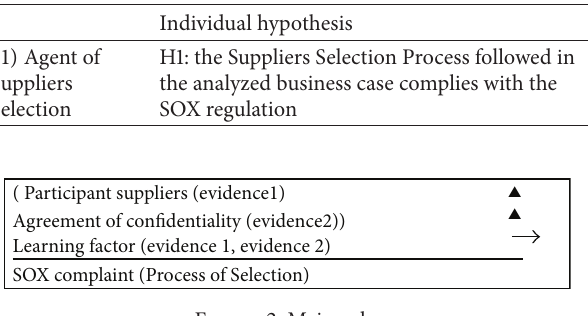
Figure 2: Main rule.